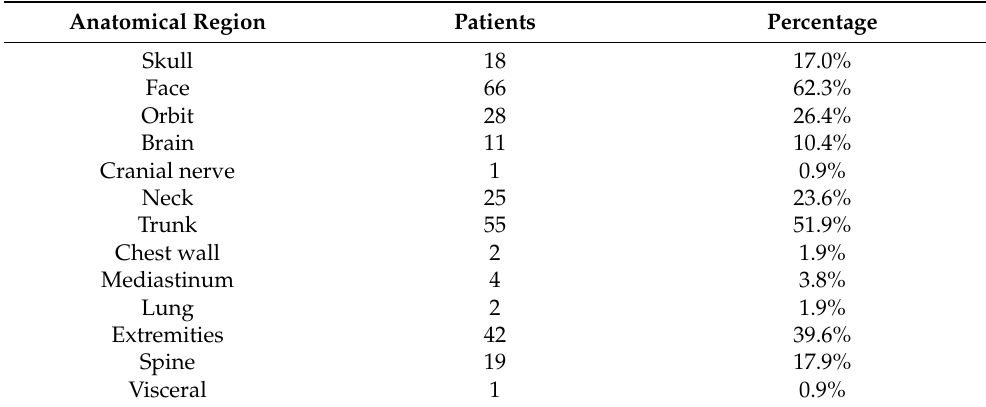
Table 1. Distribution of patients ( n = 106) with neurofibromatosis type I according to anatomical region.